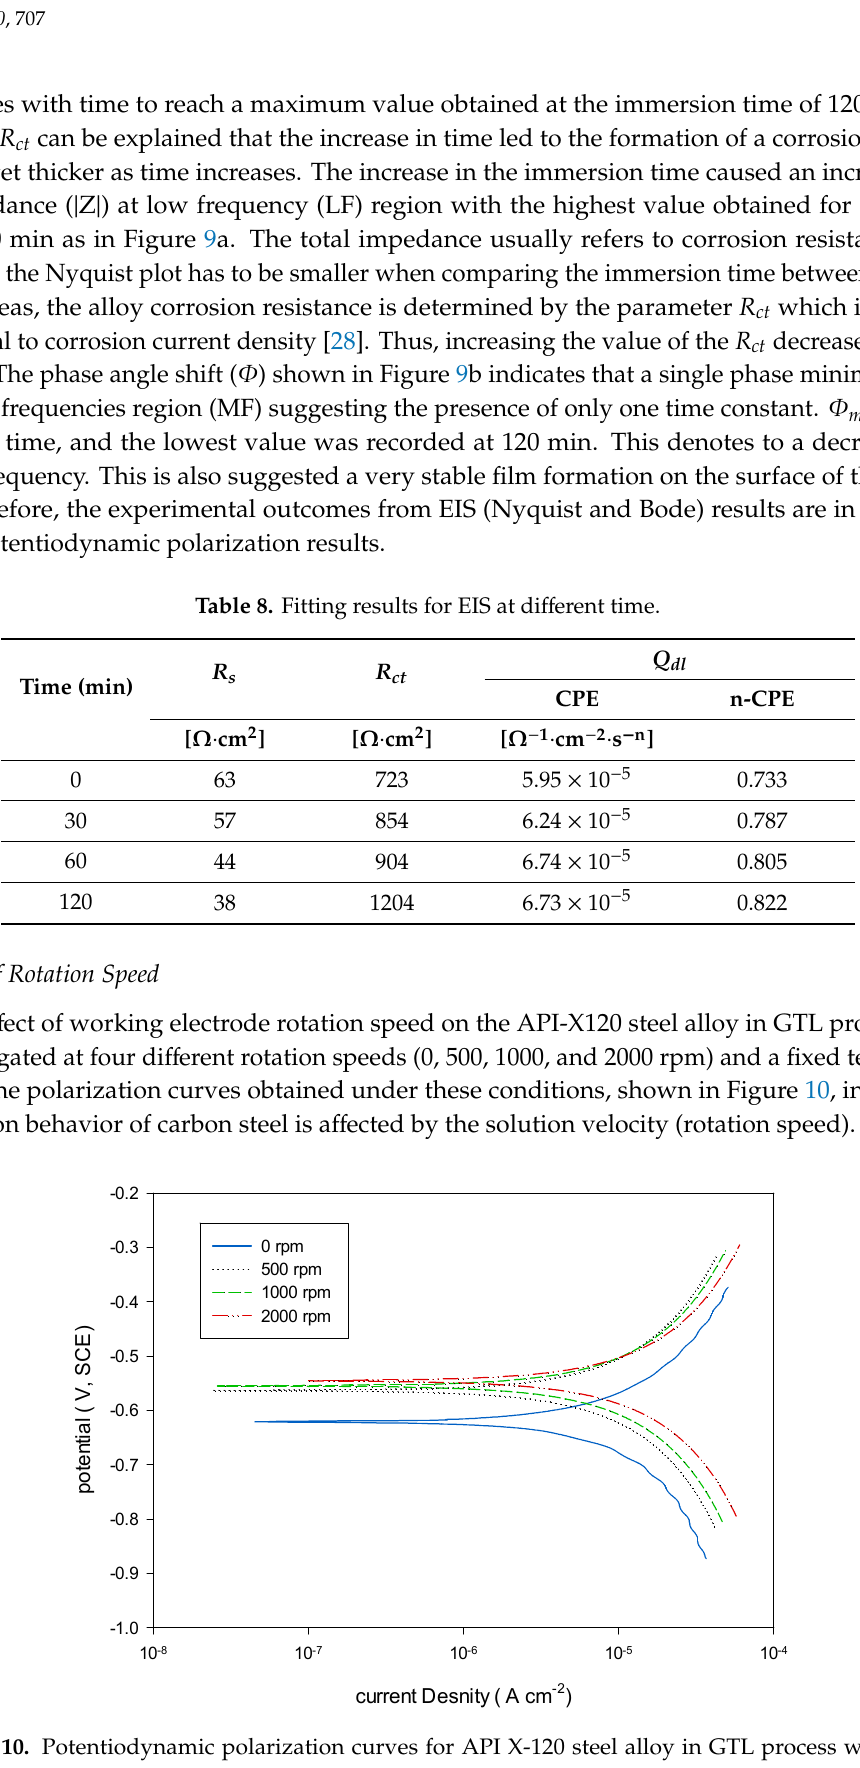
Figure 10. Potentiodynamic polarization curves for API X-120 steel alloy in GTL process water at di ff erent solution